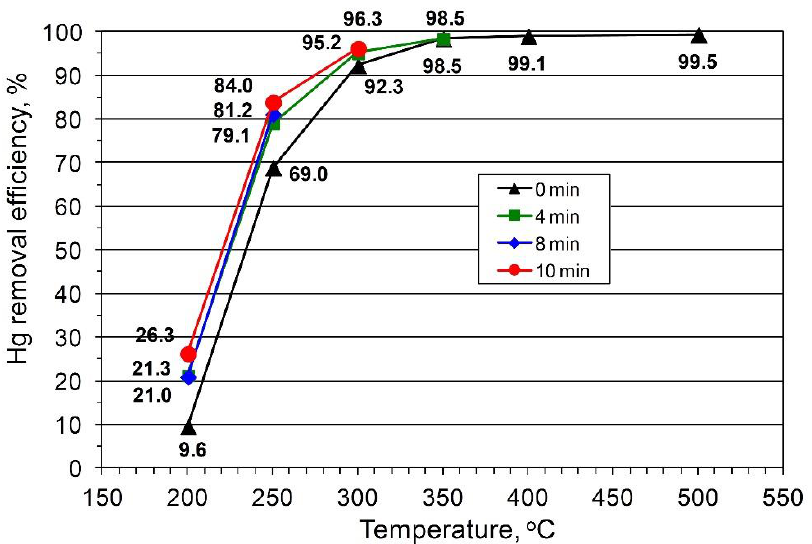
Figure 1. The average percentage efficiency of Hg removal from coal under low-temperature pyrolysis for lignite (BC1, BC2); dependence on process temperature at different residence times (0, 4, 8, 10 min).